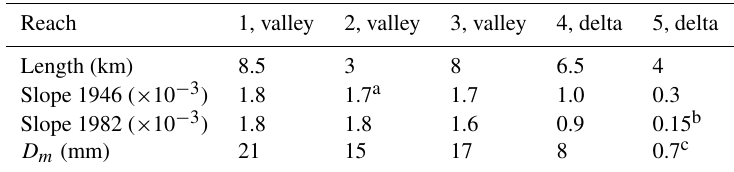
Table 3. Slope and mean grain size of the alluvial material for the five reaches of the lower Llobregat. Note the small slope change with time (1946–1982) (Prats-Puntí, 2018).